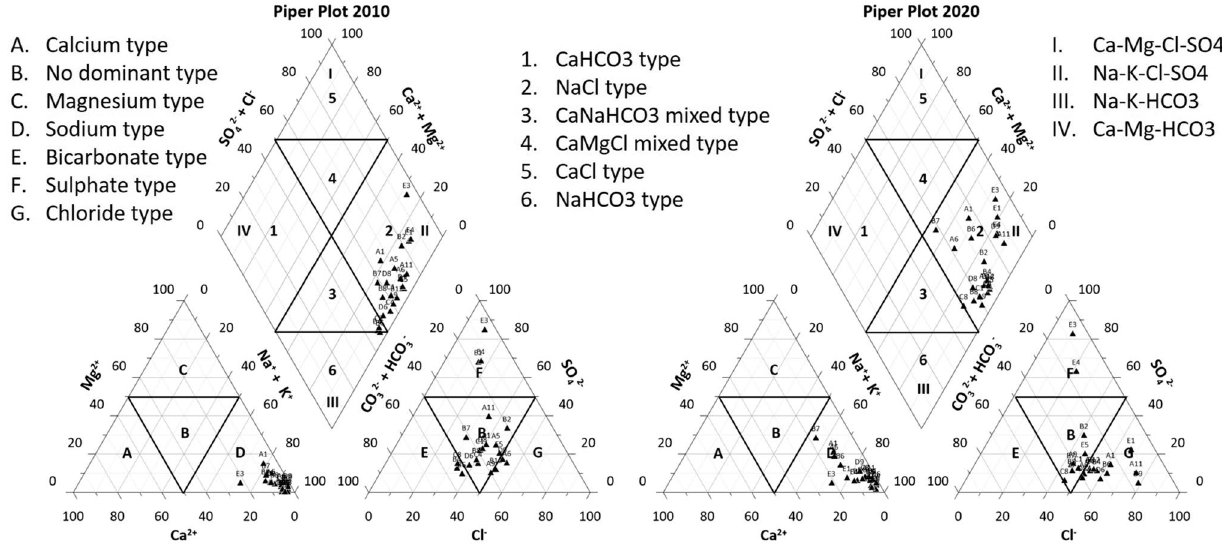
Fig. 6 Piper (1944) plot trilinear plot diagrams showing hydrochemical characteristics of groundwater for 2010 and